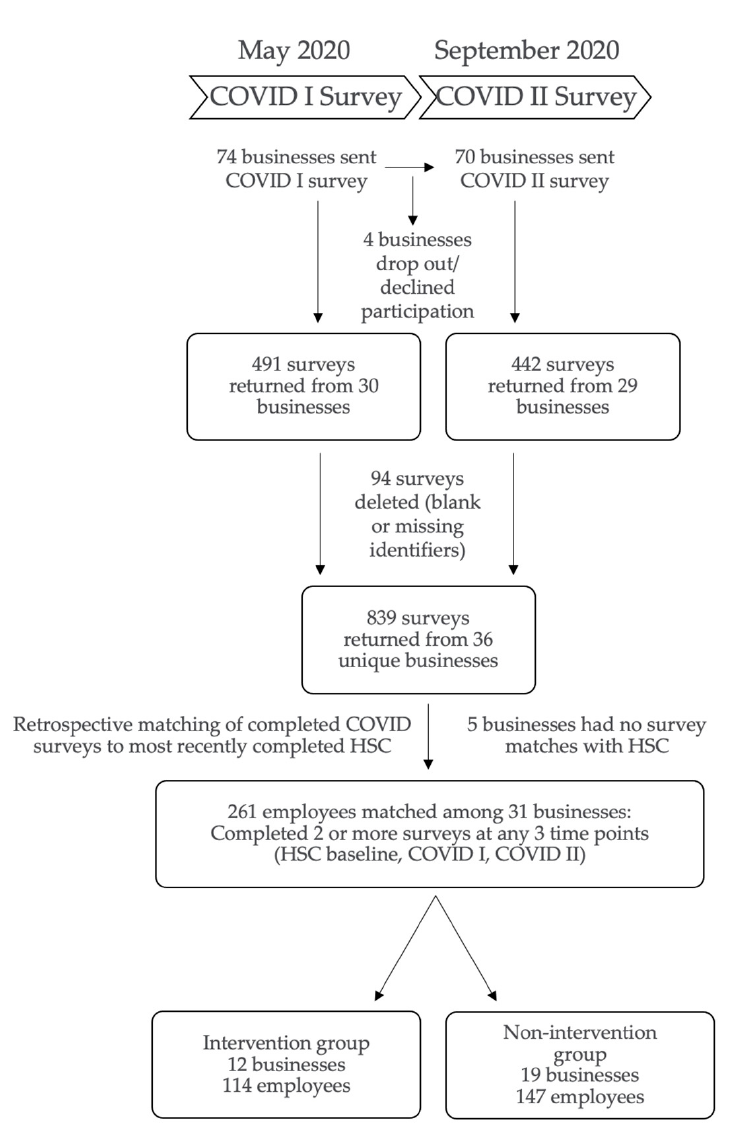
Figure 1. Design for the SSWell COVID-19 longitudinal study representing 31 unique businesses and 261 employees .